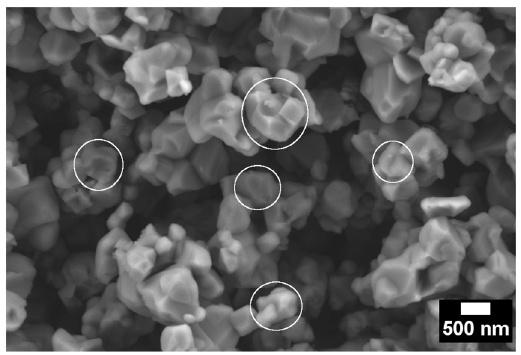
Figure 8. Non-dispersed LTO particles revealing possible surface cleavage or fracture